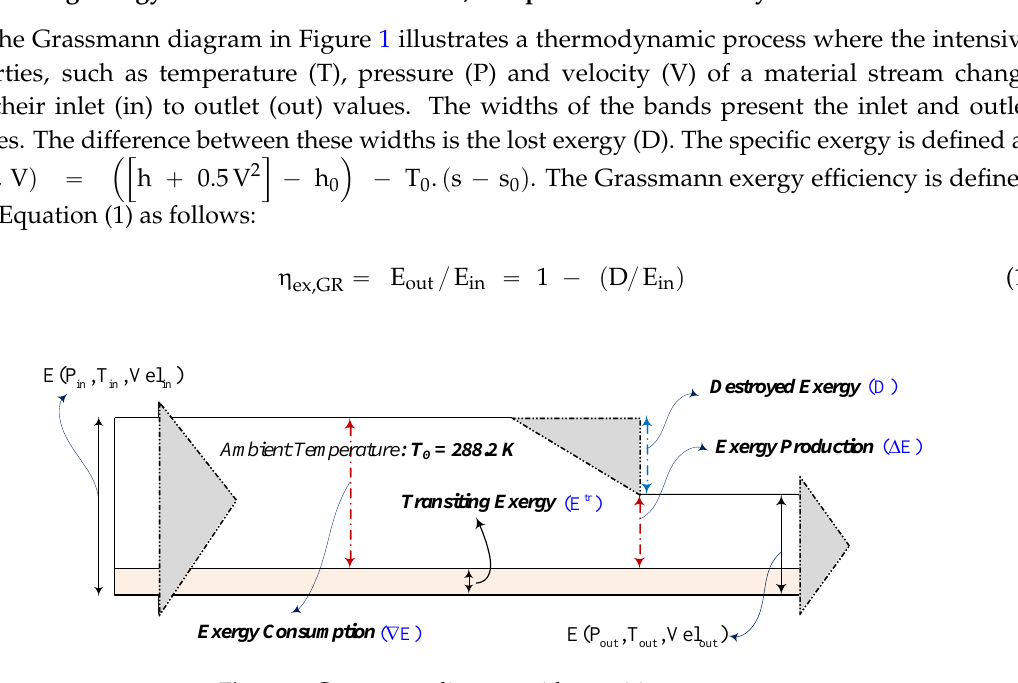
Figure 1. Grassmann diagram with transiting exergy.